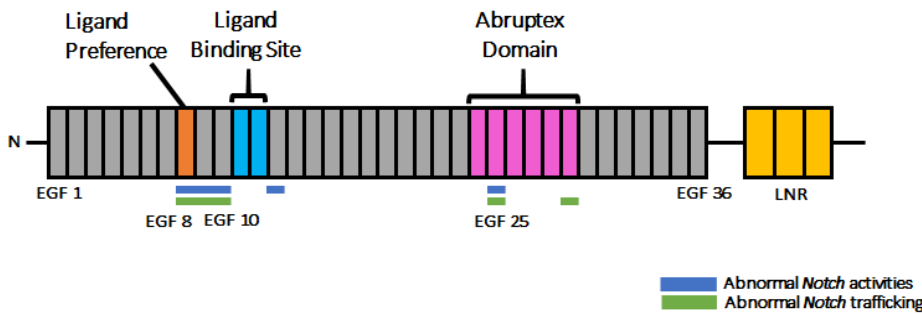
Figure 7. EGF-like repeats 8–10 and 25 are particularly sensitive to amino acid substitutions. A diagram showing EGF-like repeats with amino acid substitutions that disrupted Notch activity (blue bars) and Notch trafficking (green bars). The Abruptex domain (magenta), ligand-preference site (brown), and ligand-binding site (light blue) are also indicated. LNR repeats are shown in yellow.